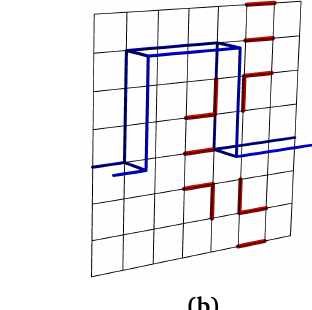
Figure 4: Cube ( A a cubic lattice.